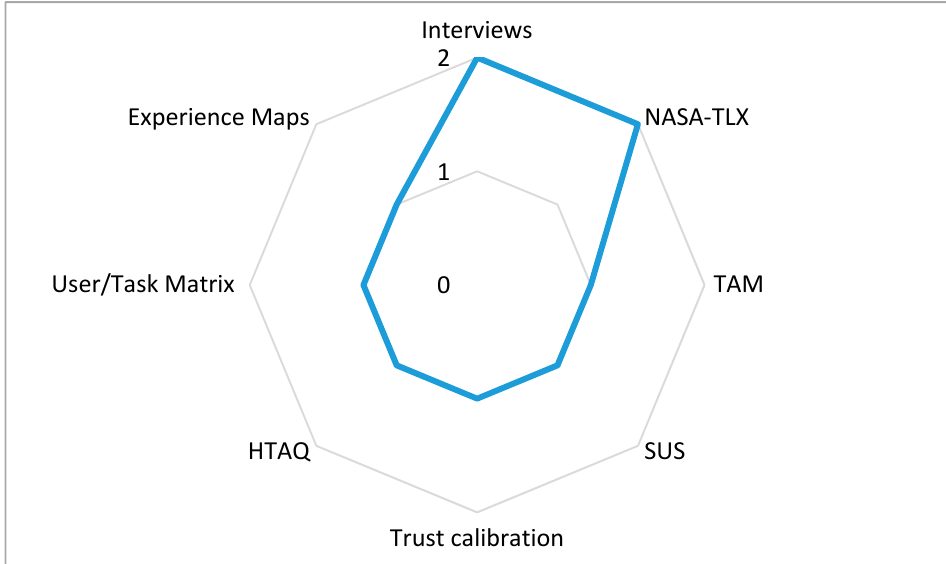
Figure 7. Distribution of cognitive ergonomics assessment tools used in the reviewed studies.